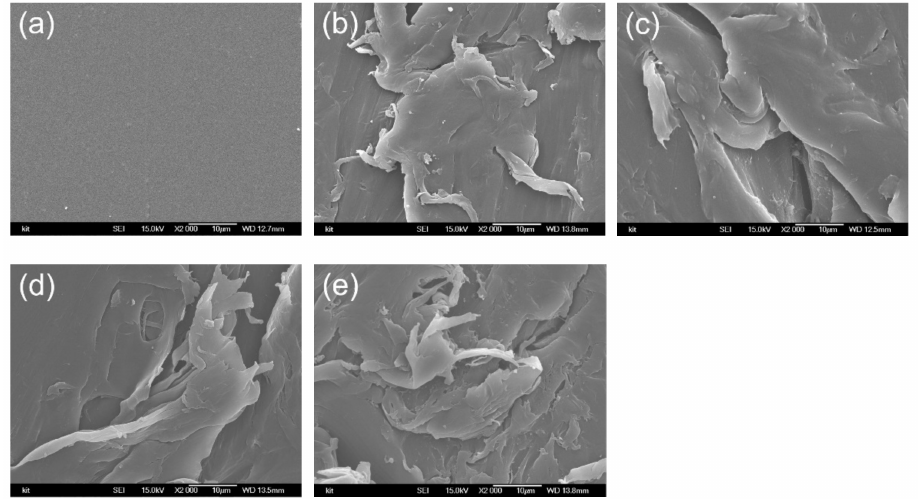
Figure 12. SEM images of polyethylene terephthalate (PET) aggregate: ( a ) 0 kGy; ( b ) 25 kGy;